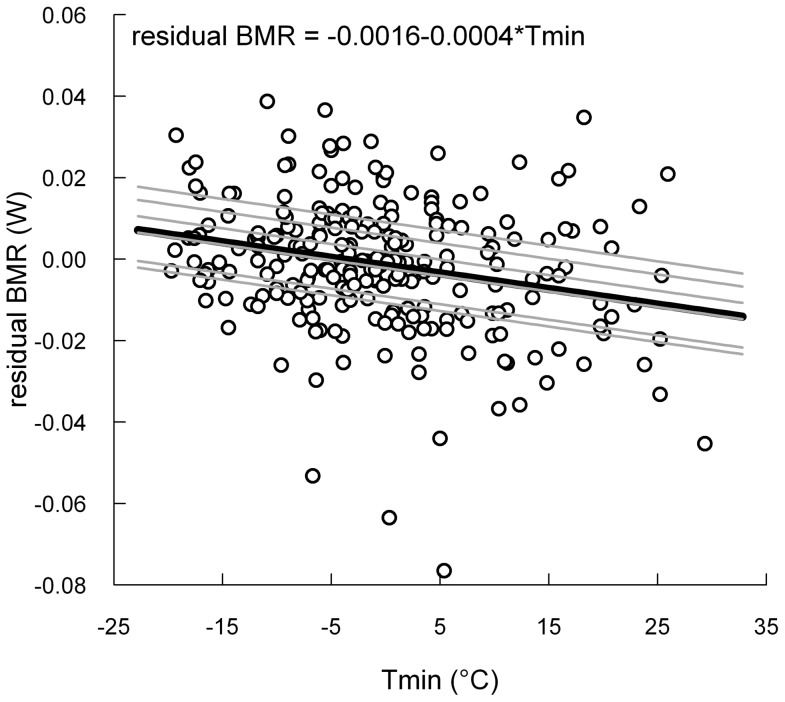
Relationship between mass and sex independent BMR and the natural range of minimal ambient temperature.Residual BMR were extracted from an ANCOVA controlling for body mass and sex. Population-average reaction norm is represented by the black line while grey lines represent reaction norms of individuals caught more than five times.